Question: Does the plotted quantity increase or decrease?
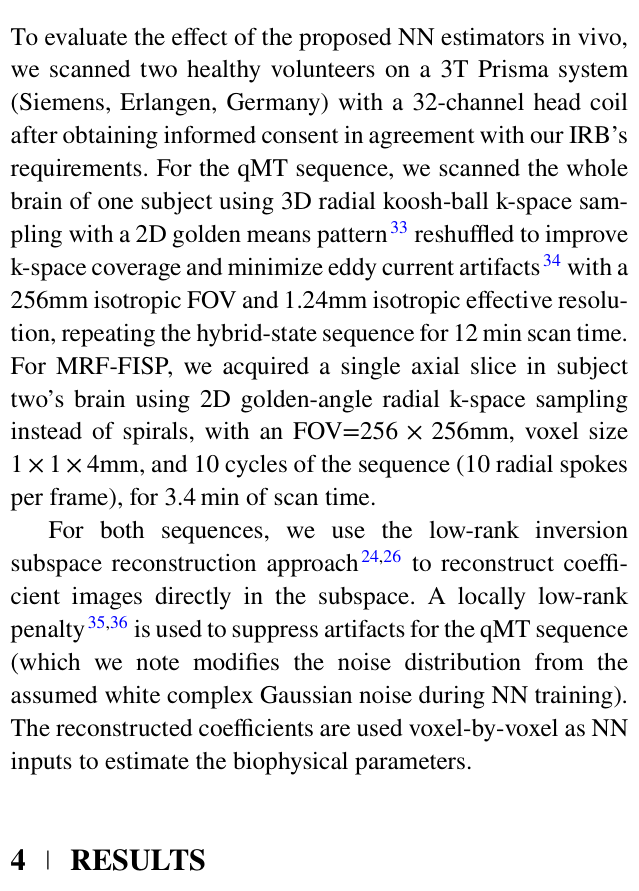
Answer: decreasing